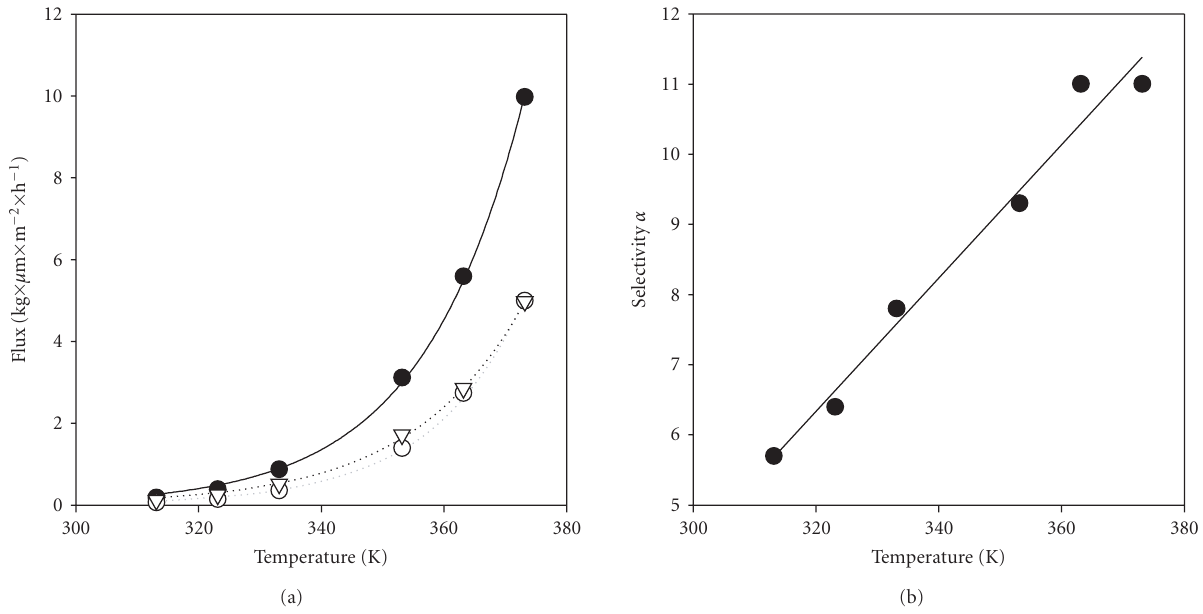
Figure 12: (a) Temperature-dependent pervaporation experiments (8 wt% phenol in feed) with an E-MAA 27 membrane ionically cross- linked with 10% Al 3+ , total flux ( • ), partial water flux ( (cid:2) ), and partial phenol flux ( (cid:4) ) and (b) separation factor.